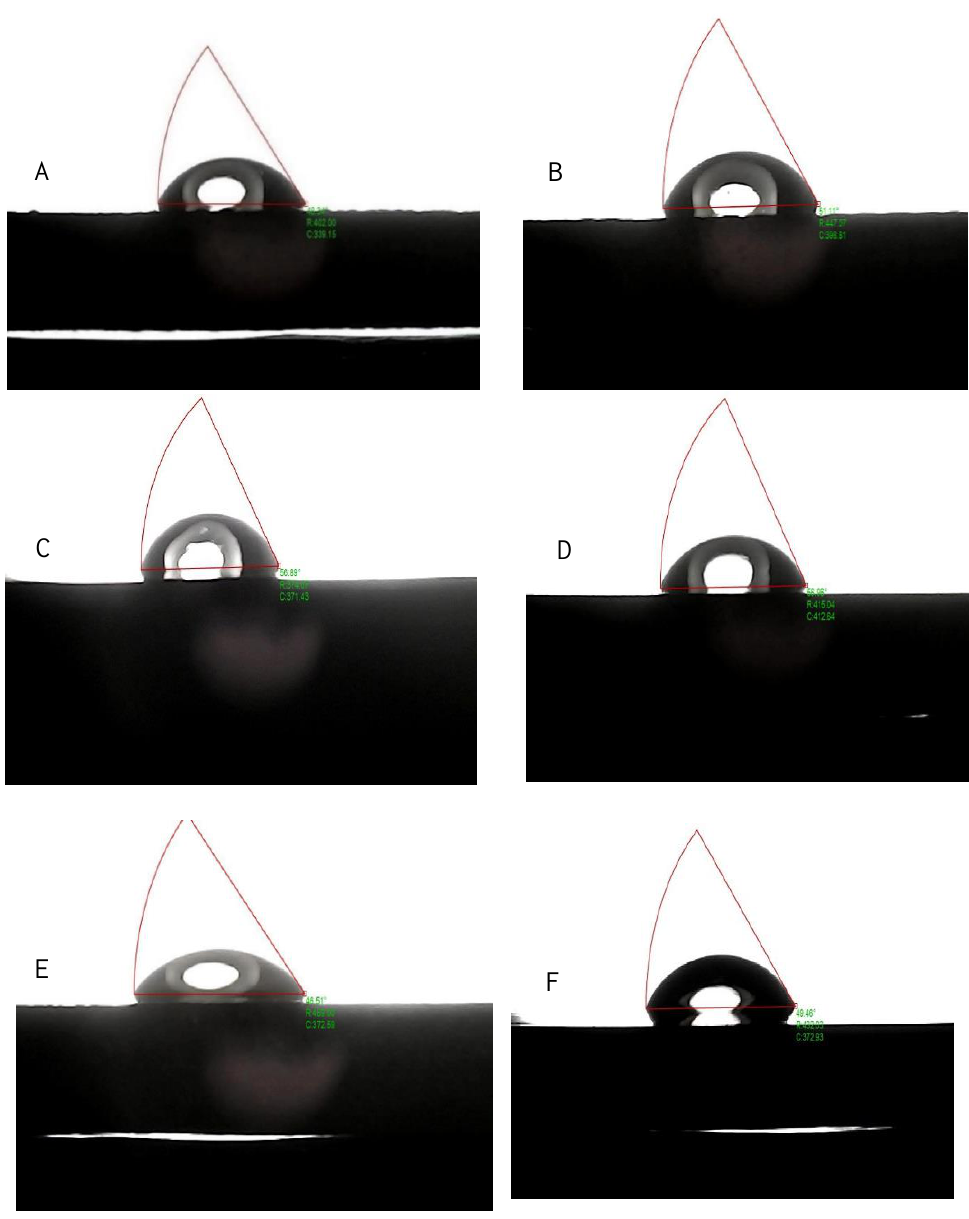
Figure 7: WCAs of ZnONPs/epoxy nanocomposite at the ZnO volume contents (A) 0%, (B) 0.1%, (C) 0.3%, (E) 0.5%, and (F)